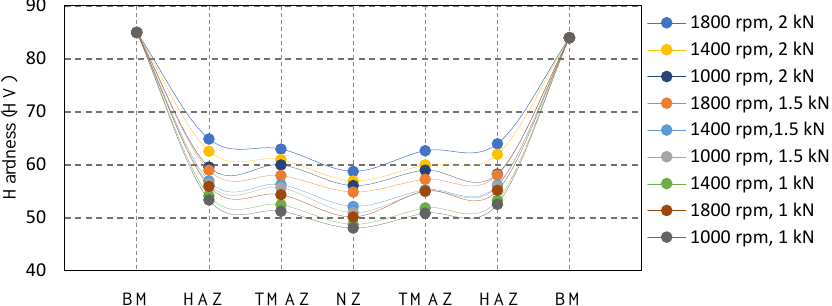
Figure 10. Hardness of welded 6063-T6 samples for various rotation speed and axial force (TS: 4 mm/min).